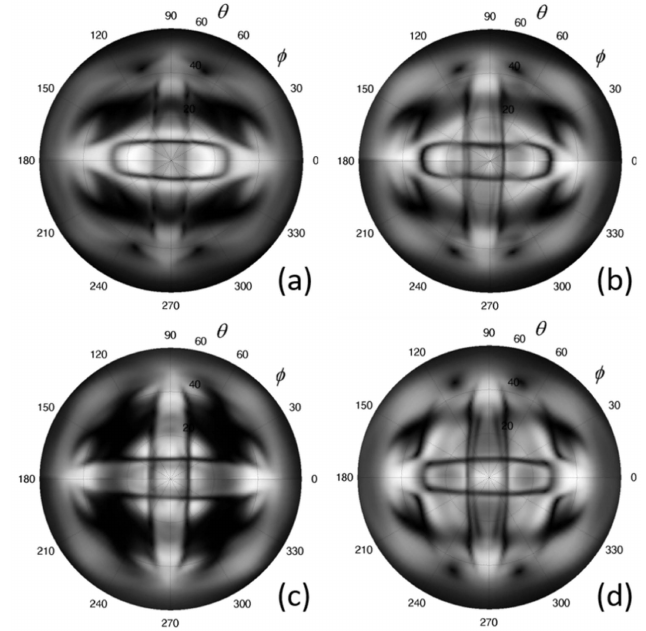
Figure 10. H-UPS recordings of a cross-ply C/E laminate at f = 5 MHz: [0 ˝ ,90 ˝ ,90 ˝ ,0 ˝ ] ( a ); [0 ˝ ,W,90 ˝ ,90 ˝ ,0 ˝ ] ( b ); [0 ˝ ,90 ˝ ,W,90 ˝ ,0 ˝ ] ( c ) and [0 ˝ ,W,90 ˝ ,90 ˝ ,W,0 ˝ ] (d). “W” stands for the position of the water-filled delamination.